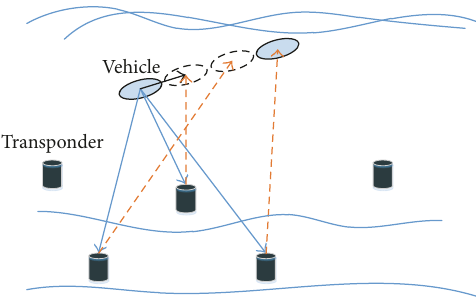
Figure 1: Network model of the underwater